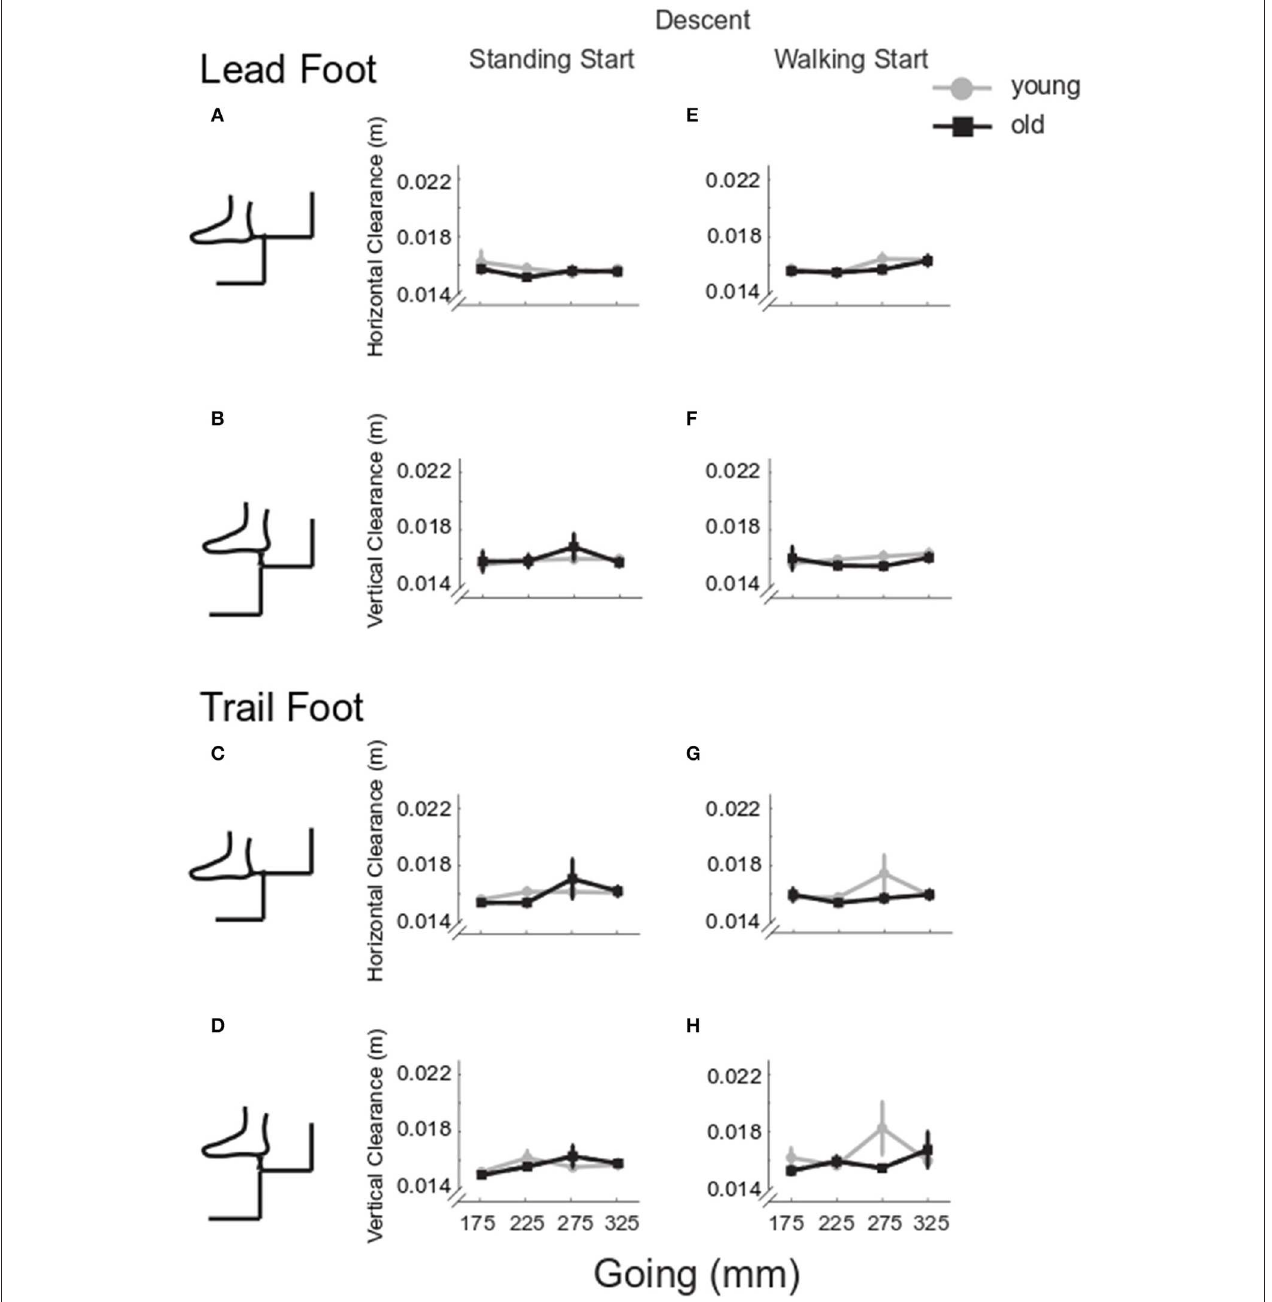
FIGURE 8 | Group clearance in descent. Group mean and SE for older (black) and younger (gray) lead and trail foot horizontal (A,C,E,G) and vertical clearance (B,D,F,H) in stair descent at the four goings, from a standing (left column) and a walking start (right column).